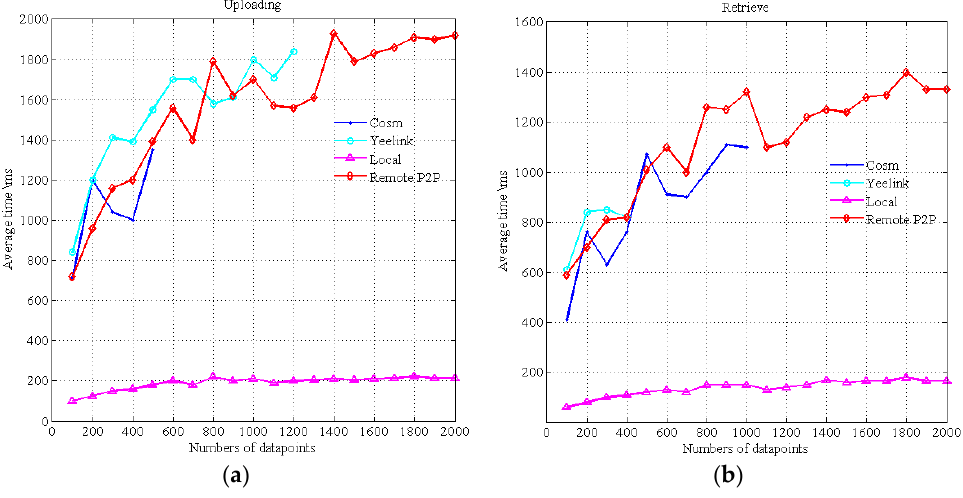
Figure 19. ( a ) average uploading time; ( b ) average retrieval time.